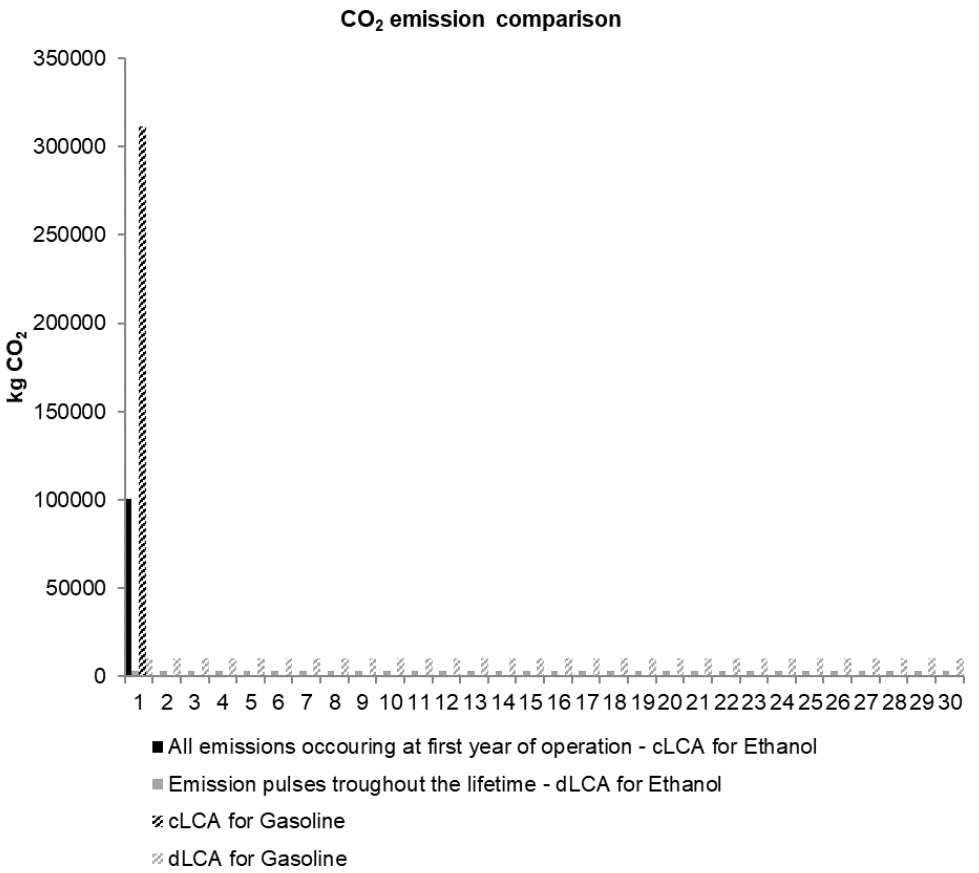
Figure 2. Example of the difference in conventional CO 2 emissions and actual emissions during a factory lifetime. Comparison between our case study for ethanol [24] and gasoline, without allocation, in a cradle-to-gate approach [33], for a 30-year operation lifetime.